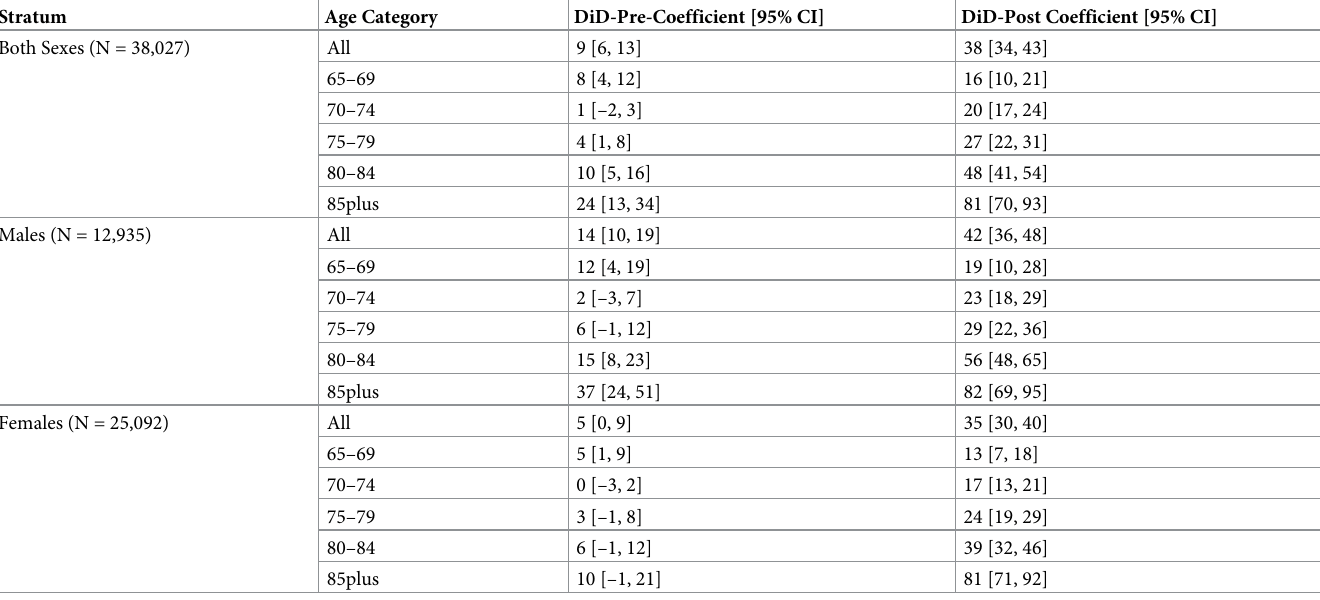
Table 2. Difference in overall health care costs one-year before (DiD-Pre) and one-year after (DiD-Post) bereavement compared to those who did not. Stratum Age Category Both Sexes (N =